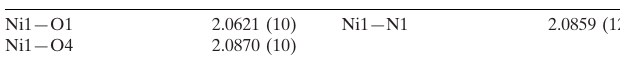
Selected bond lengths (A˚ ).